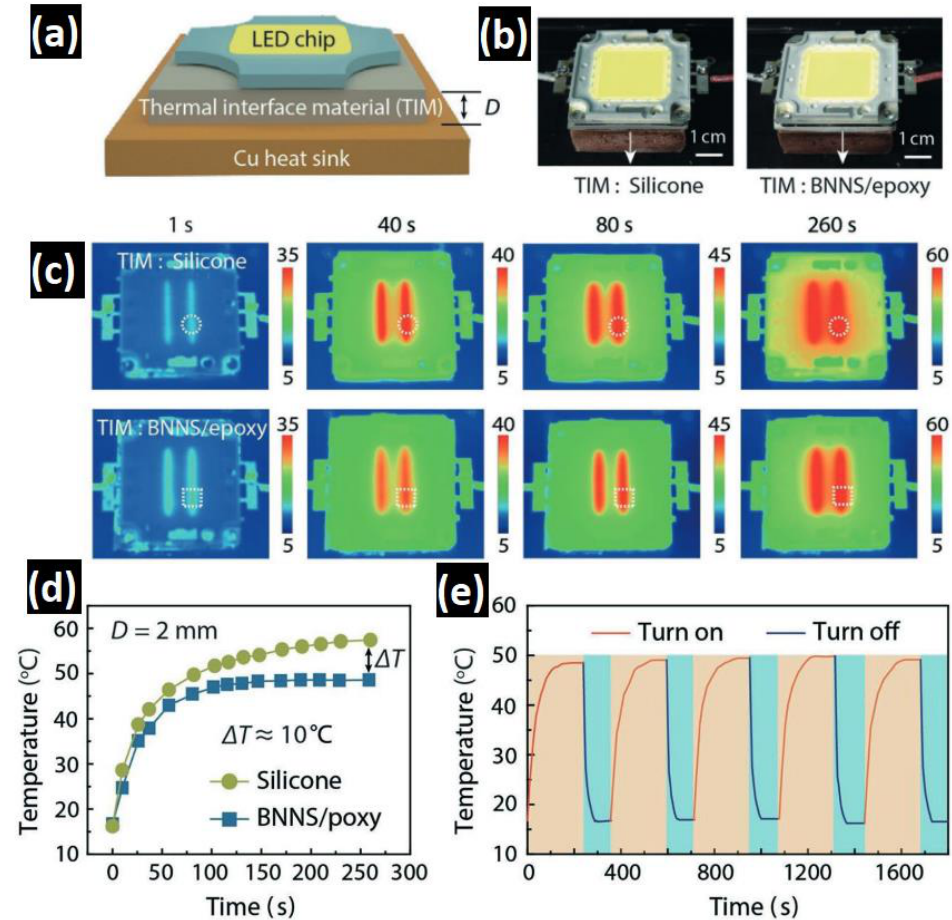
Figure 9. Demonstration of the as-mentioned BNNSs/epoxy composite as a TIM: ( a ) Schematic diagram of a light-emitting device (LED) chip integrated with a TIM and a Cu heat sink; ( b ) Optical images showing two LED chips integrated with commercial silicone and our BNNSs/epoxy composite as TIMs (both TIMs are 40 × 40 × 2 mm in size); ( c ) Sequential top-view infrared images of the two LED chips, indicating more efficient thermal dissipation using the present composite as TIM; ( d ) Comparison between the temperature increase of the same spot on the two chips, depicted by the white dotted circle and square, respectively, in ( c ); ( e ) The chip temperature monitored during cyclic “on” (4 min) and “off” (2 min) states, indicating the thermal stability of our BNNSs/epoxy composite (Reprinted with permission from WILEY-VCH, Copyrights 2019) [52].